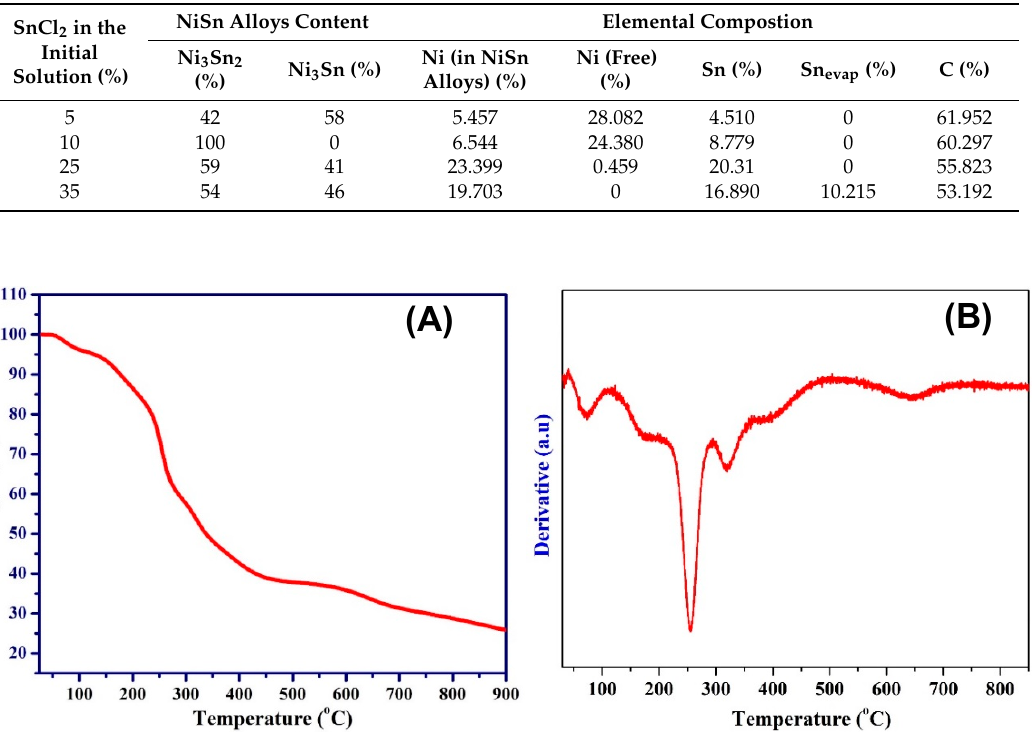
Figure 4 . Thermal gravimetric analysis (TGA) ( A ), and first derivative for the TGA data ( B ) for an electrospun mat containing 10 wt % tin precursor.